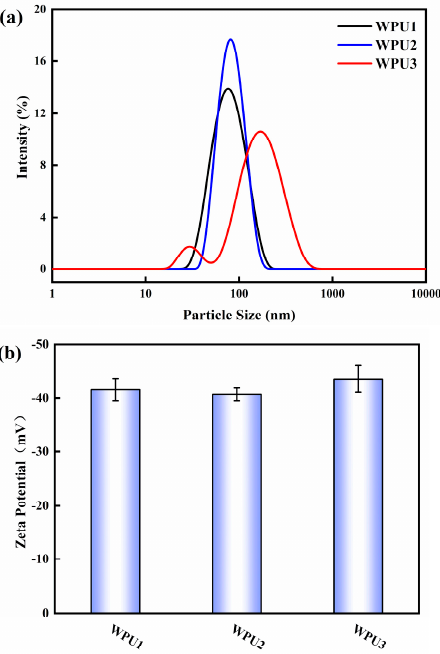
Figure 2. Particle size and distribution of WPU ( a ) and their zeta potential ( b ).